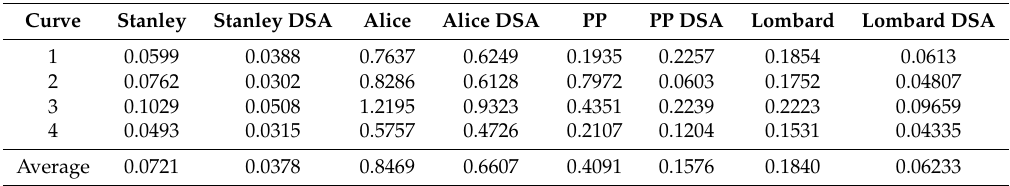
Table 2. Error comparison in sharp curves of different Lateral Control methods for the simulated path. Results are expressed in